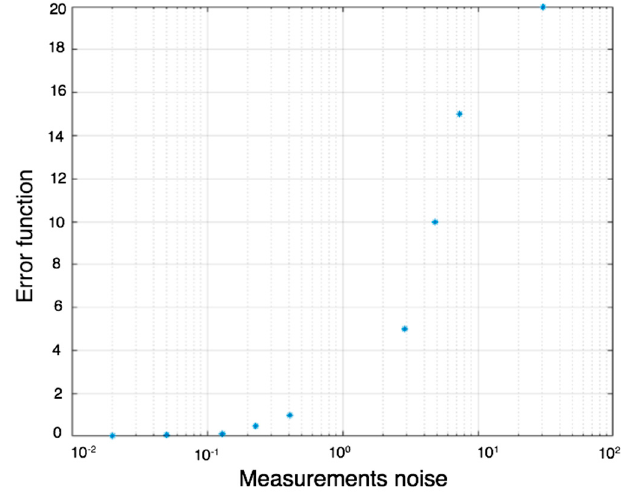
Figure 2. Error function as a function of the measurement noise.